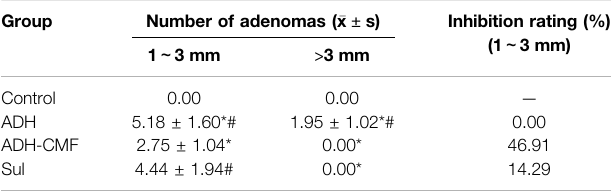
TABLE 1 | The number of adenomas in the range of 1 ∼ 3 mm and larger than 3 mm in the intestinal tract of mice. Group Number of adenomas ( (cid:1) x ± s)